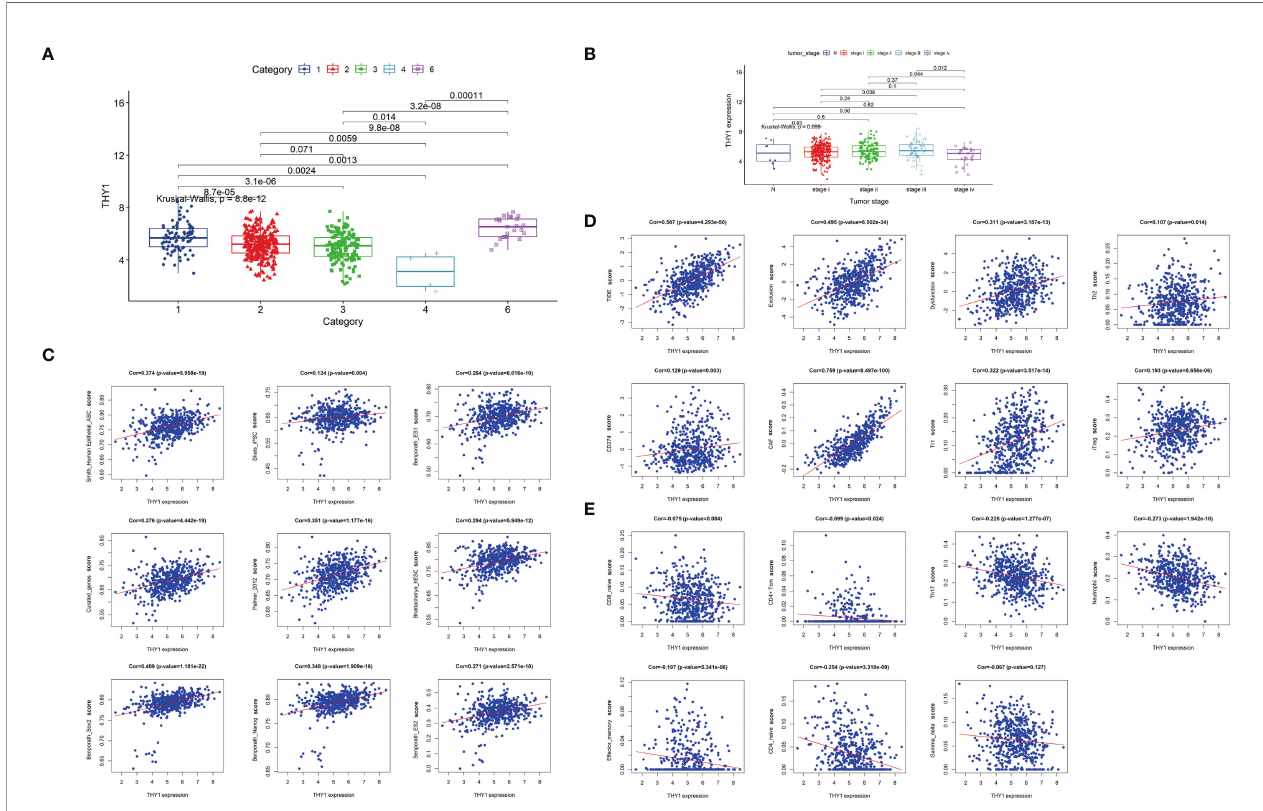
FIGURE 6 | Characteristics of THY1 in LUAD patients. (A) THY1 expression of LUAD patients in six immune subtypes: C1, wound healing; C2, IFN- g dominant; C3, in fl ammatory; C4, lymphocyte depleted; and C6. TGF-b dominant. (B) mRNA expression levels of THY1 in different tumor clinical stages (N and stage i-iv) of LUAD patients. (C) Correlation analysis of THY1 and various cancer stemness features. (D) Correlation analysis of THY1 with immunosuppressive markers. (E) Correlation analysis of THY1 with immunoactivating markers. Cor,